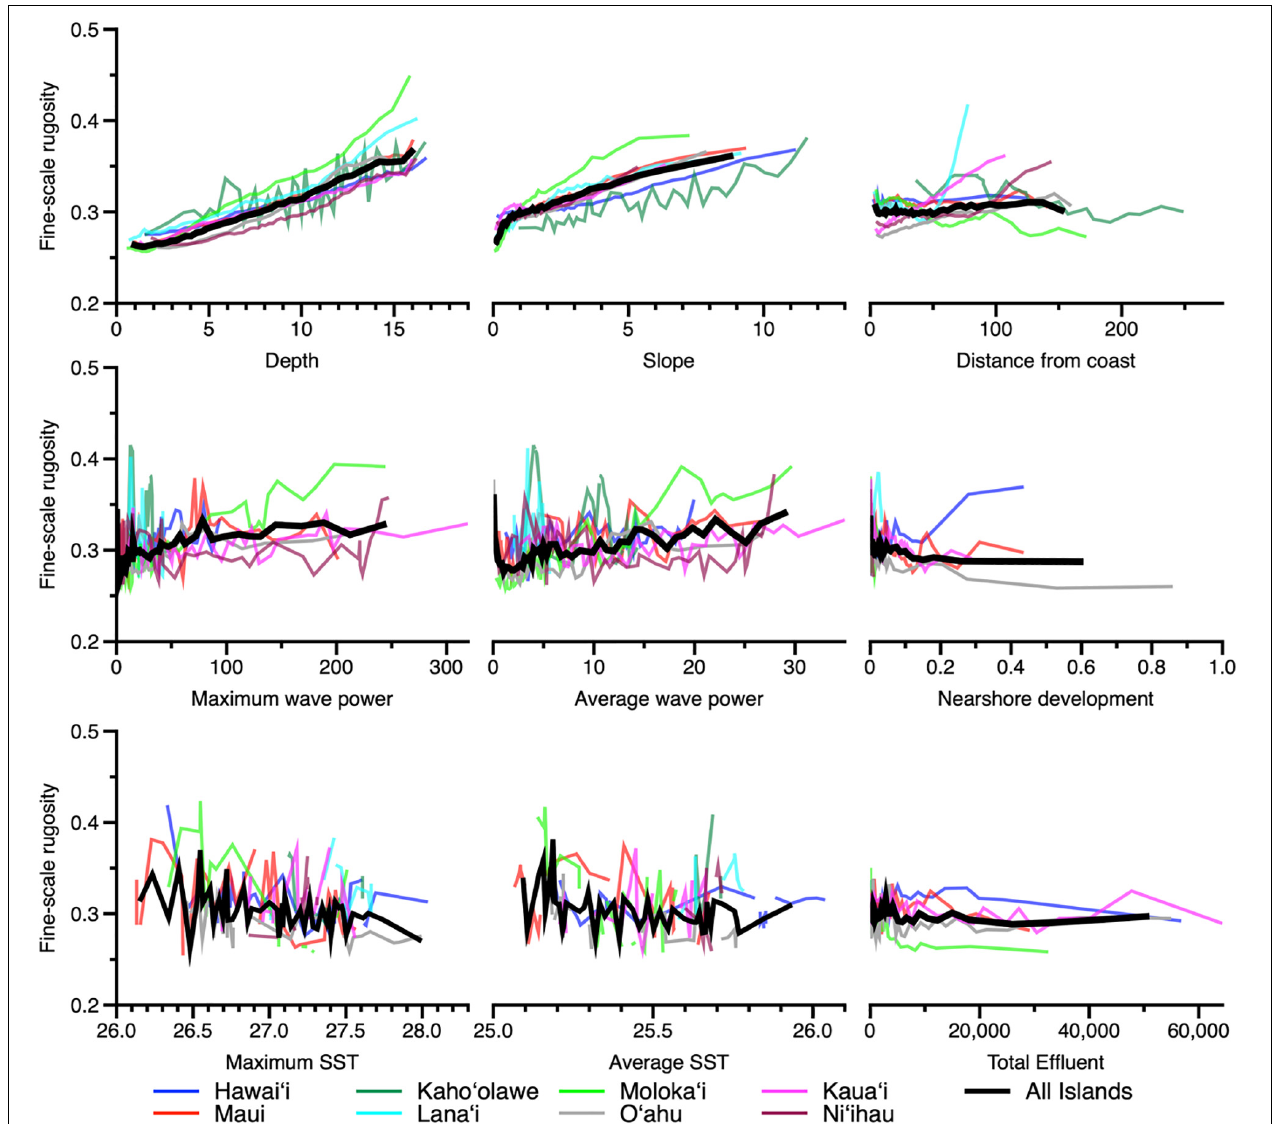
FIGURE 7 | Partial dependence plots indicating the relationship between fine-scale rugosity and the top nine variables presented in Figure 6 . Colored lines indicate relationships by island, and thick black lines indicate relationships for all islands combined. Coarse-scale rugosity is provided in Appendix Figure A4